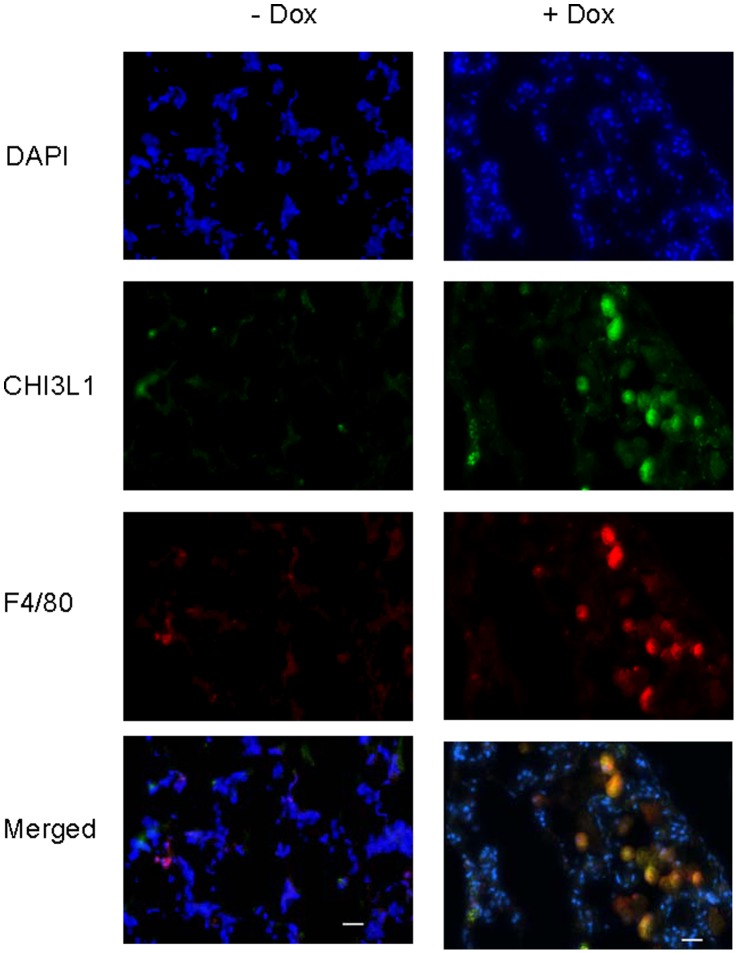
Immunofluorescent co-staining of CHI3L1 and F4/80 in the lung of CCSP-rtTA/(TetO)7-CMV-Stat3C mice.CCSP-rtTA/(TetO)7-CMV-Stat3C bitransgenic mice were treated (+DOX) or untreated (-DOX) with doxycycline. Immunofluorescent staining of lung sections was performed using anti-CHI3L1 and F4/80 antibodies. Co-localization of both staining was observed in the merged picture. Bar represents 20 µm.